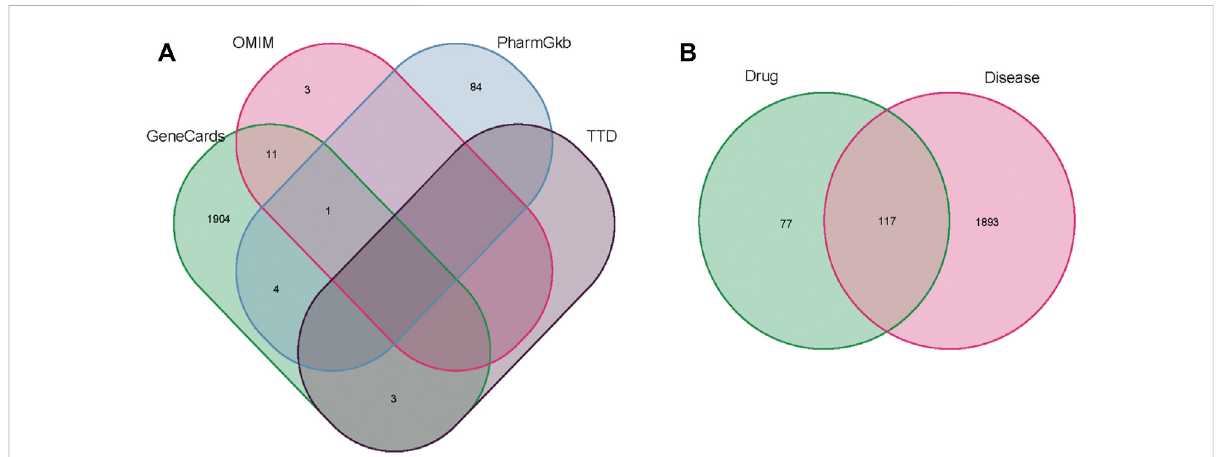
FIGURE 2 (A) The results of the Venn diagram of AAA-related targets in four databases. (B) The results of the Venn diagram of drug genes (green) and disease genes